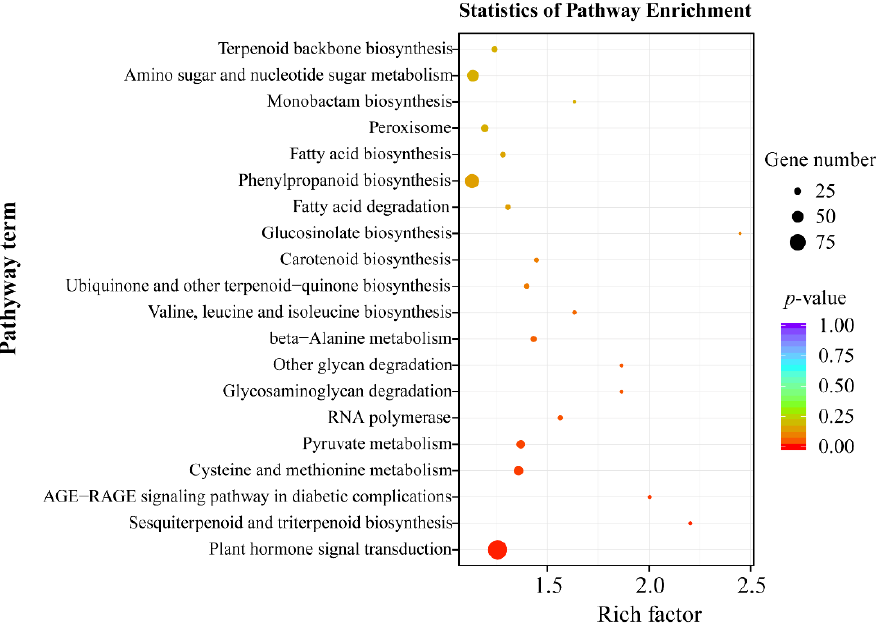
Figure 8. Kyoto Encyclopedia of Genes and Genomes (KEGG) analysis of differentially methylated region (DMR)-related genes (DMGs) in CHH type (H = A, T, or C) in SV and PV grafts (SV: grafts with strong growth vigor; PV: grafts with poor growth vigor). The circle size represents the gene number. The coloring of circles represents p -value, indicating the enrichment significance of DMGs in KEGG pathways.